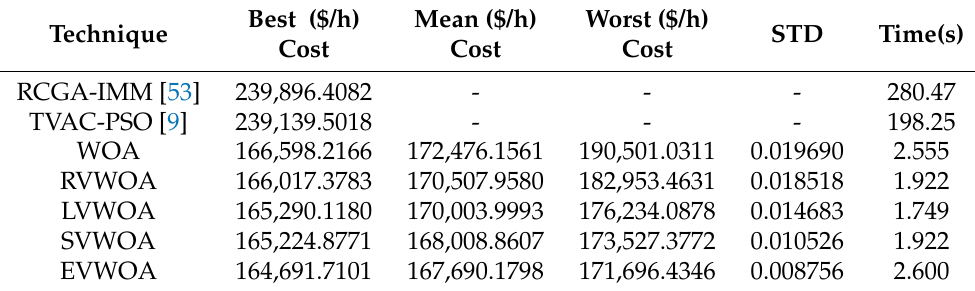
Table 15. Optimal schedule for the best cost obtained for Case study 6.